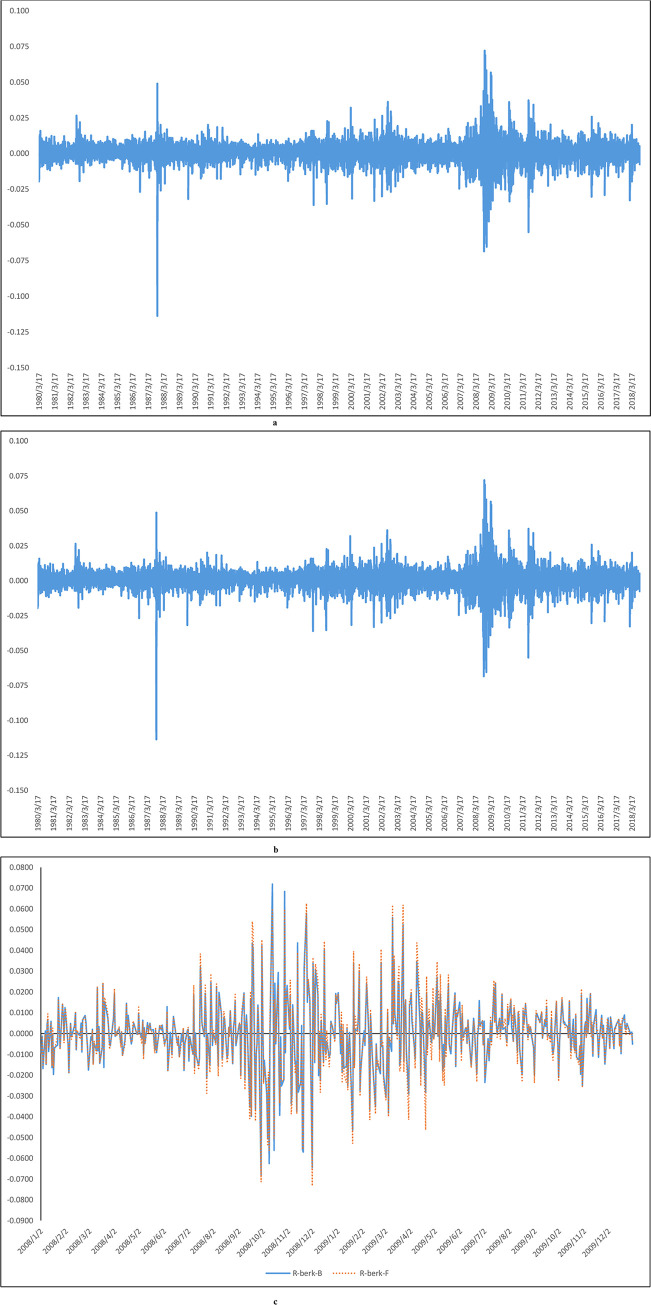
a: Buffett-factor model returns, b: five-factor model returns, c: Buffett-factor model returns and five-factor model returns for the sub-period (2008–2009). Fig 2A shows the returns of the replicating asset constructed by using the Buffett-factor model. Fig 2B shows the returns of the replicating asset constructed by using the five-factor model. We can find that the overall behavior patterns of the two replicating assets are similar to those of the original Berkshire A stock. Fig 2C overlays the information presented in Fig 2A and 2B in one plot using a shorter time frame, 2008–2009. This figure shows that the information presented in Fig 2A and 2B, which depict the returns of the replicating assets obtained from using the Buffett- and five-factor models are not identical to each other. In the figure, the maximum return of the Buffett-factor model is 7.2%; the minimum return is -0.068%. The maximum return of the five-factor model is 6.26%; the minimum return is -0.0733.